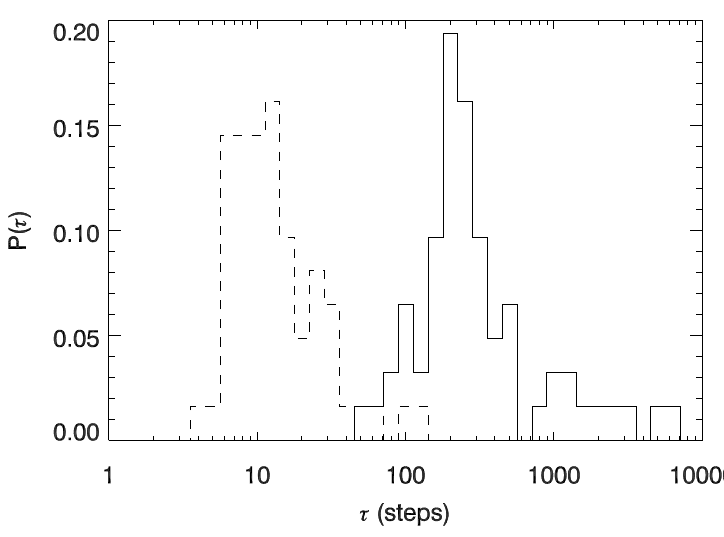
Figure 2. Relaxation time, τ , for the sixty-two pages in our sample (solid line). Times are exceptionally long, an average of 698 steps, and, on average, a factor of 50 times longer than expected for Markov models with similar sparseness (dotted line). The longest trapping times are for the pages associated with the Gaza War, the Russo-Georgian War, and the page describing Wikipedia